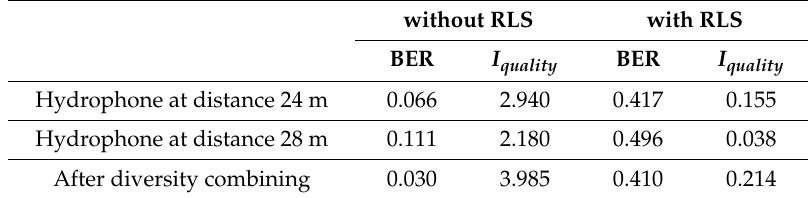
Table 2. Results for data transmission at 24 m and 28 m distances between the hydrophones and the